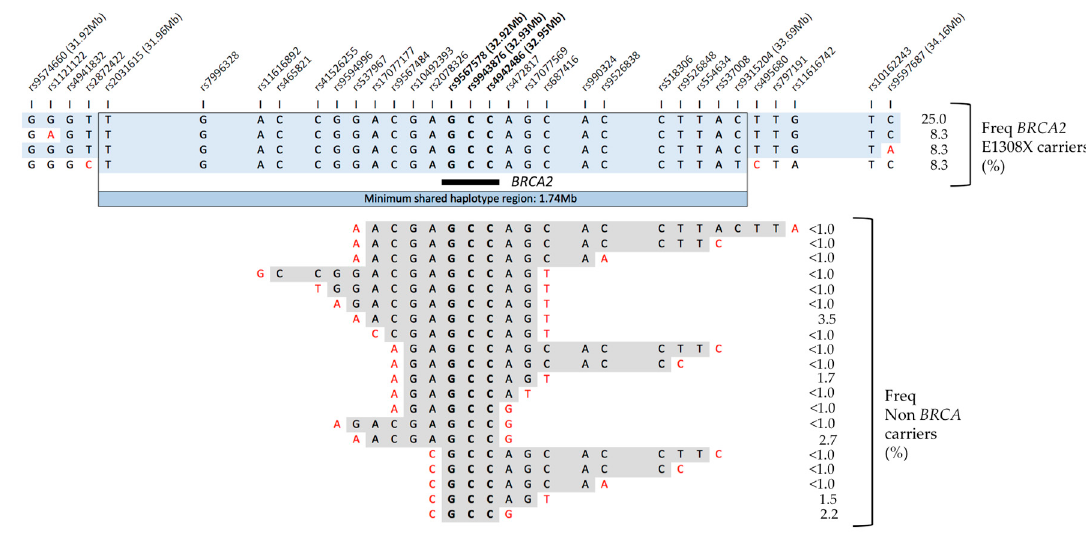
Figure 1. Shared haplotype and frequencies in a 2.24 Megabase (Mb) region around the BRCA2 gene in carriers of the E1308X pathogenic variant ( n = 6) and non-BRCA carriers ( n = 201). A total of 73 markers were phased in a 2.6 Mb region, but only 33 are represented. For non-BRCA carriers, only a fraction of the observed haplotypes are illustrated, representing the haplotypes that match those of the carriers within the BRCA2 gene.